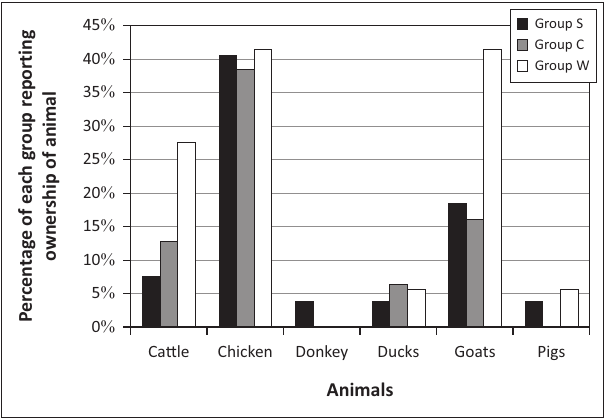
FIGURE 12: The different patterns of animal ownership for the three groups in